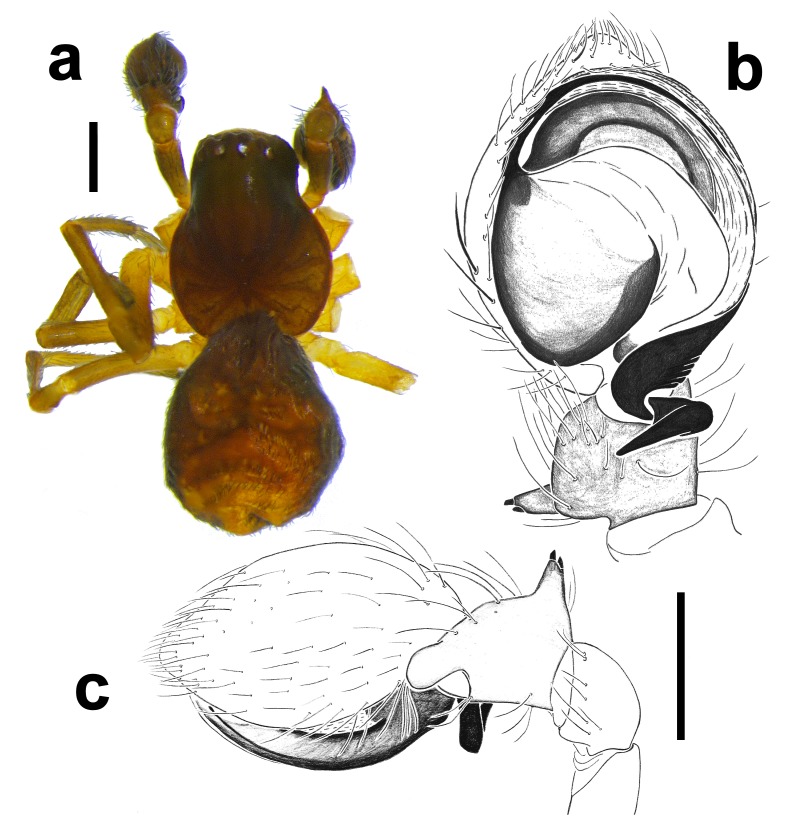
Dictyna
pusilla Thorell, 1856. a: male, dorsal habitus, scale = 0.6 mm; b: left male palp, ventral, scale = 0.2 mm; c: left male palp, retrolateral, scale = 0.2 mm.